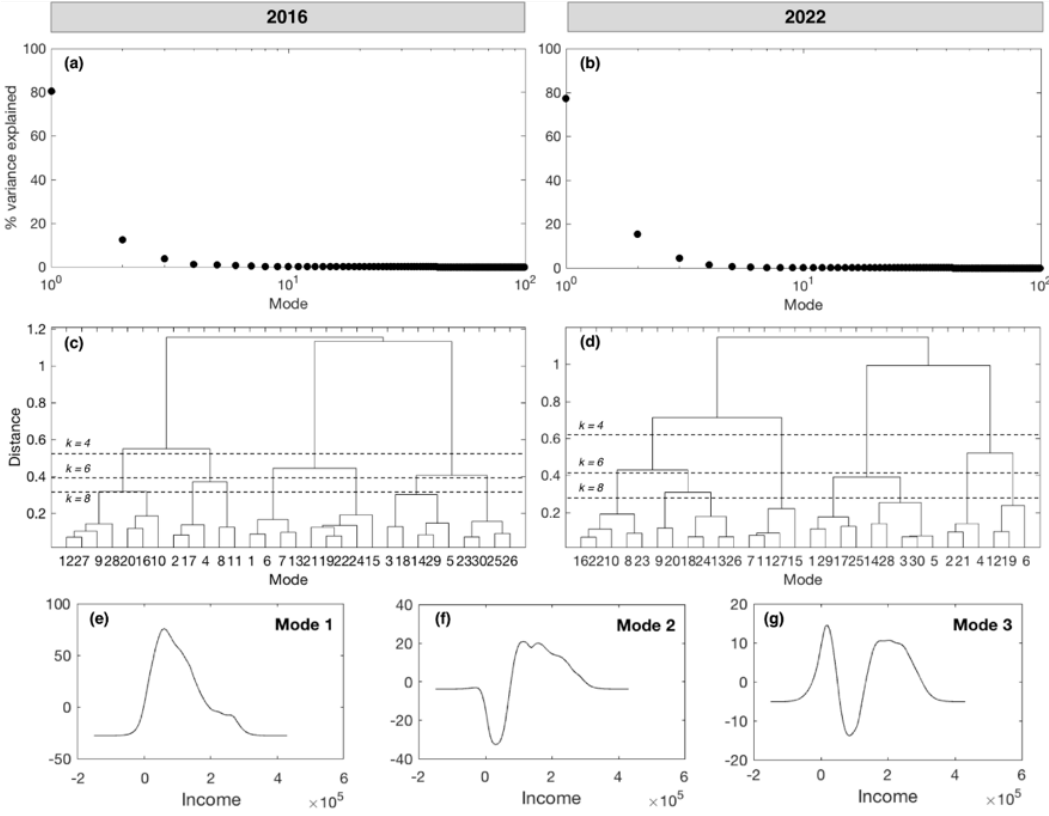
Figure 1. ( a , b ) Percentage of variance explained by the PC modes, for ( a ) 2016 and ( b ) 2022; ( c , d ) Dendrogram showing cluster structure and distances between clusters, for ( c ) 2016 and ( d ) 2022. Only ~35 subclusters are shown for ease of display. Vertical positions of the solid horizontal bars linking different clusters indicate the distance between those clusters. Dashed lines show possible cut off levels related to decreasing distances between clusters below; ( e – g ) First three PCA modes for 2016 income data ( y -axis is unitless), which reveal the features that contain the most variance across each dataset.